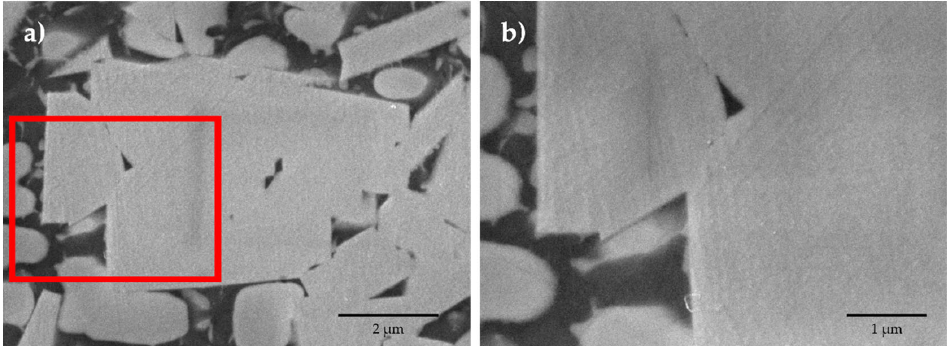
Figure 9. ( a ) WC coalescence at the inner region for E a39 , ( b ) higher magnification image taken from the marked rectangle in ( a ).